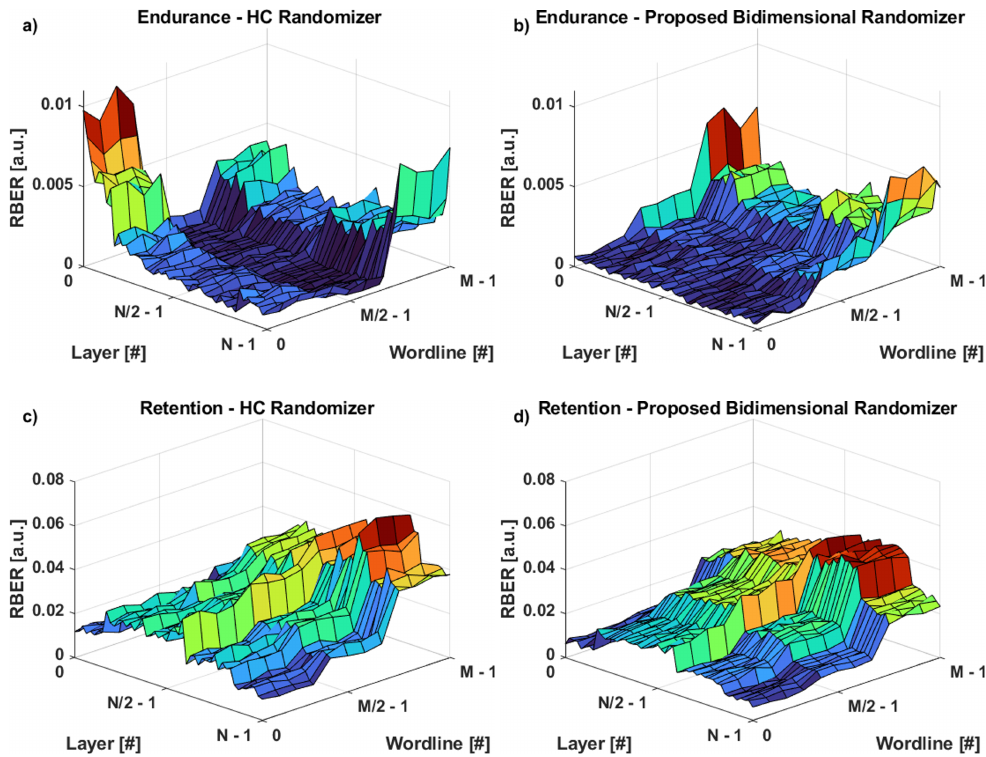
Figure 11. Topological characterization of the RBER in a 3D NAND Flash memory for Endurance and Retention working corners when the input data come from an HC randomizer ( a , c ) or from our proposed method ( b , d